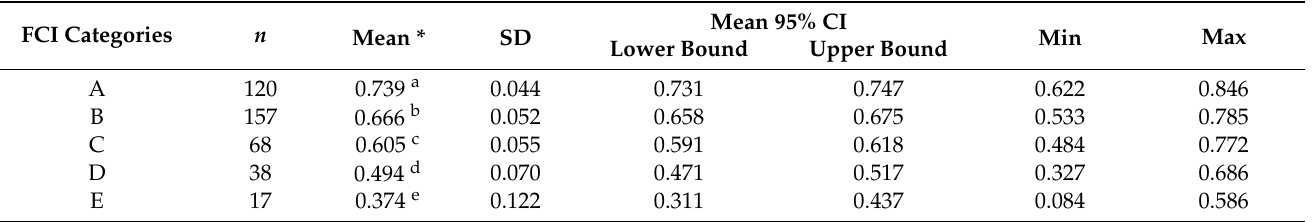
Table 1. Statistic descriptive analysis of the Hip Congruency Index by F é d é ration Cynologique Interna- tionale categories.